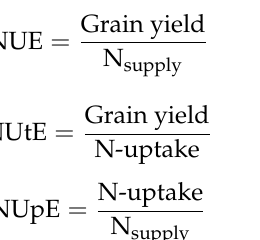
Table S2: The correlation of wheat grain yield with agronomic traits, water use efficiency